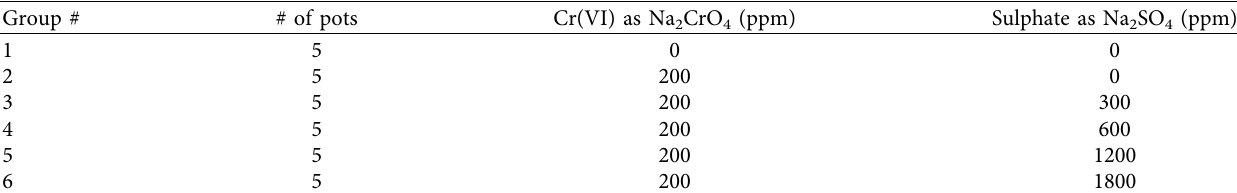
Table 3: Concentrations of components of the irrigation